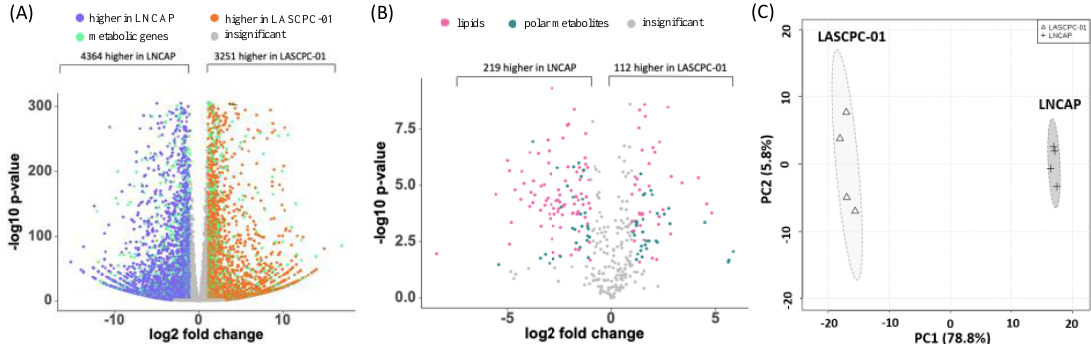
Figure 1. Transcriptome and metabolome profiles of LASCPC-01 and LNCAP cell lines. ( A ) 7615 transcripts were differentially expressed between LASCPC-01 and LNCAP cell lines (adjusted p -value < 0.05; fold change (LASCPC-01/LNCAP) > 2); Orange: expression levels were higher in LASCPC-01; Purple: expression levels were higher in LNCAP; Green: transcripts involved in metabolic processes; Grey: adjusted p -value > 0.05; or –2 < fold change (LASCPC-01/LNCAP) < 2. ( B ) 197 annotated metabolites were significantly different between two cell lines (adjust p -value < 0.05, fold change (LASCPC-01/LNCAP) > 2); Pink: lipids; Green: polar metabolites. ( C ) Principal component analysis of all annotated metabolites demonstrating the large overall metabolic differences between both cell types.